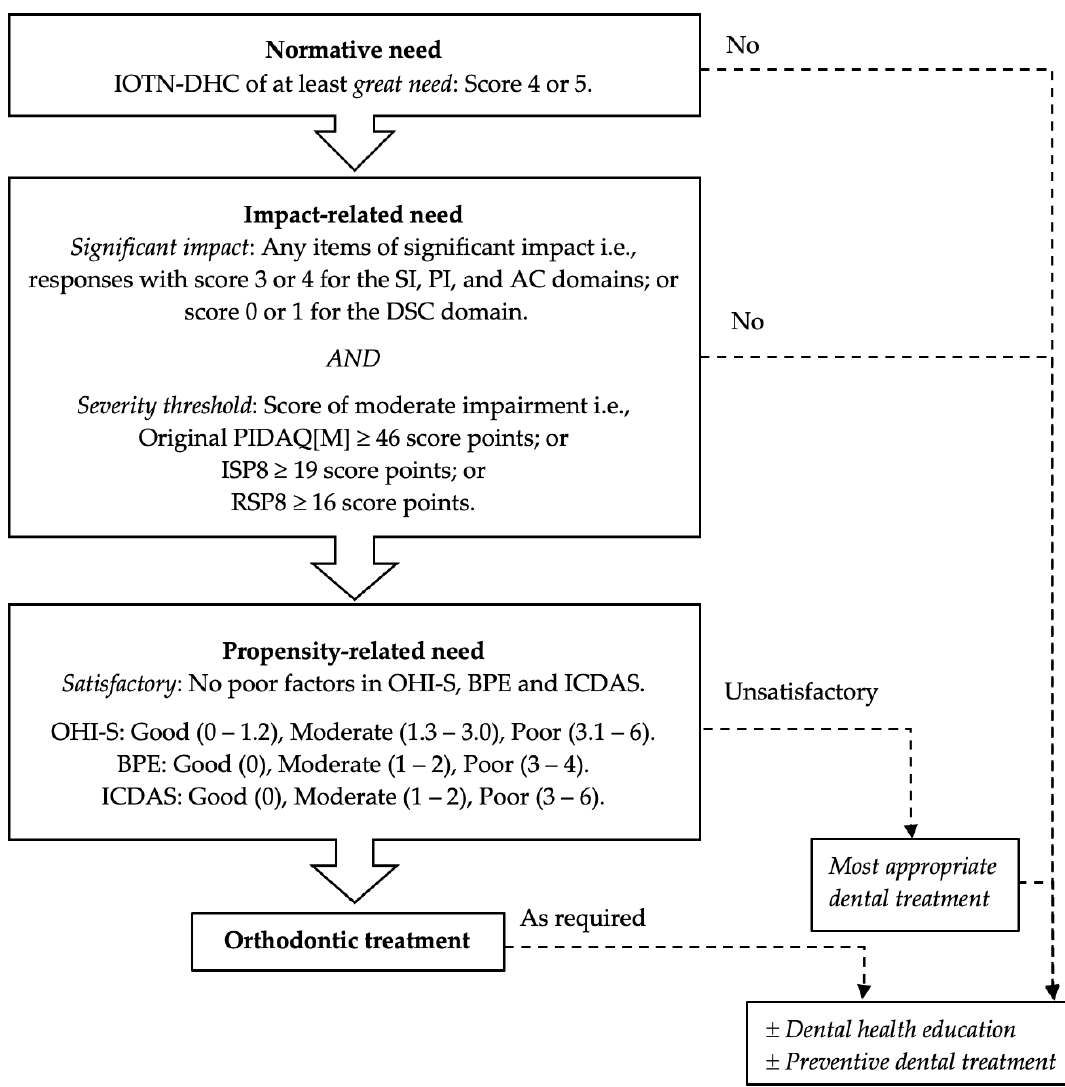
Figure 1. Flowchart of the sociodental approach for assessing orthodontic treatment need.